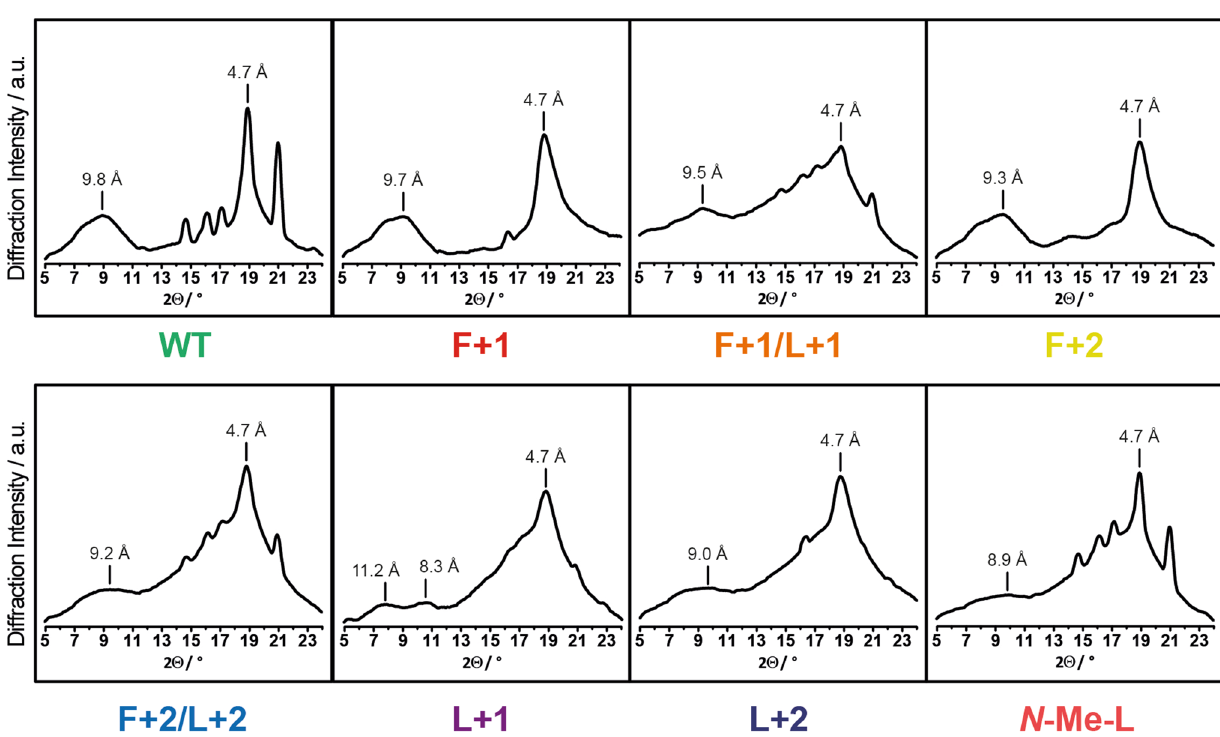
Figure 5. X-ray diffraction patterns of fibrils formed from the Aβ 40 variants. Characteristic inter-sheet (8.3–11.2 Å) and inter-strand (4.7 Å) distances are assigned. Other reflections in the range of 2θ = 14–18° and at 21° result from salts present in the amyloid samples and are not of